Question: Summarize what this figure shows in one sentence.
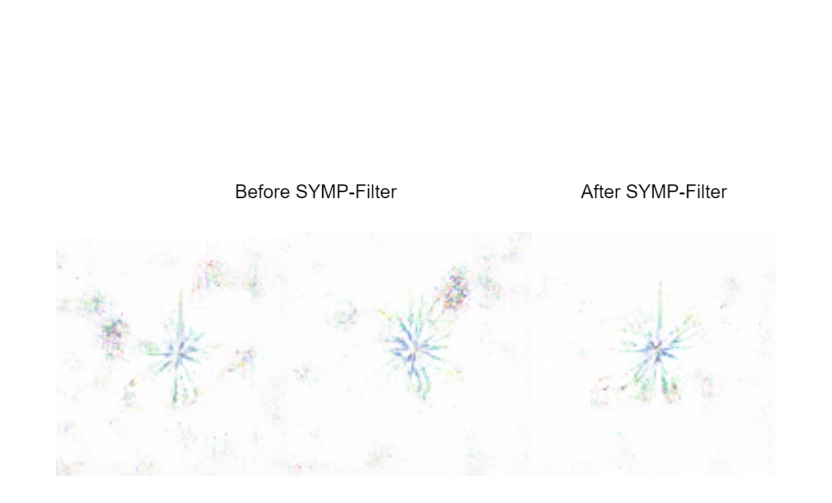
Answer: Qualitative results of our SYMP-Filter algorithm. Three synthetic images of Cellulosic were generated using a cGAN trained on Aug∗. The two images on the left contain unprocessed cGAN output, while the rightmost image shows filtered output.